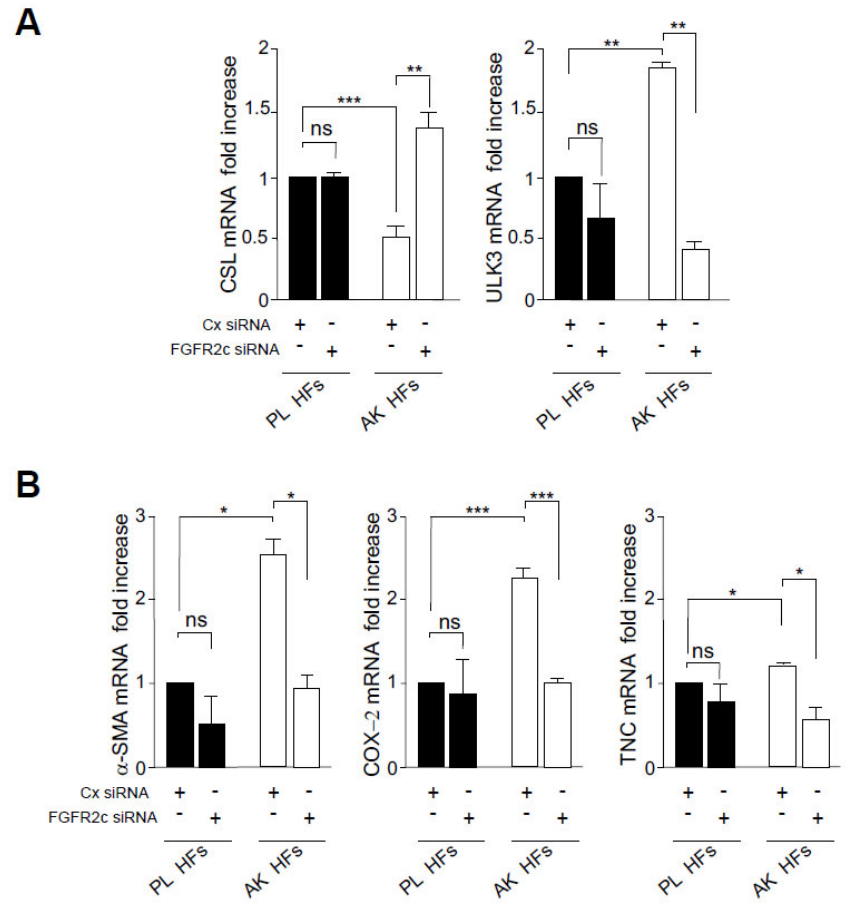
Figure 7. Highly expressed FGFR2c triggers CAF gene induction in AK KIN I-derived HFs. Primary cultures of HFs isolated from #2PL and #2AK samples were transfected with FGFR2c siRNA and Cx siRNA as above. Real-time RT-PCR analysis reveals a repressive effect of FGFR2c depletion on the increase of ULK3 and on the repression of CSL ( A ), as well as on the more pronounced expression of CAF genes ( B ) displayed by AK cultures compared to their corresponding controls. Results are expressed as mean values ± SD. The student’s t-test was performed, and significance levels are defined as p < 0.05. * p < 0.05; ** p < 0.01; *** p < 0.001; ns not signi fi cant.